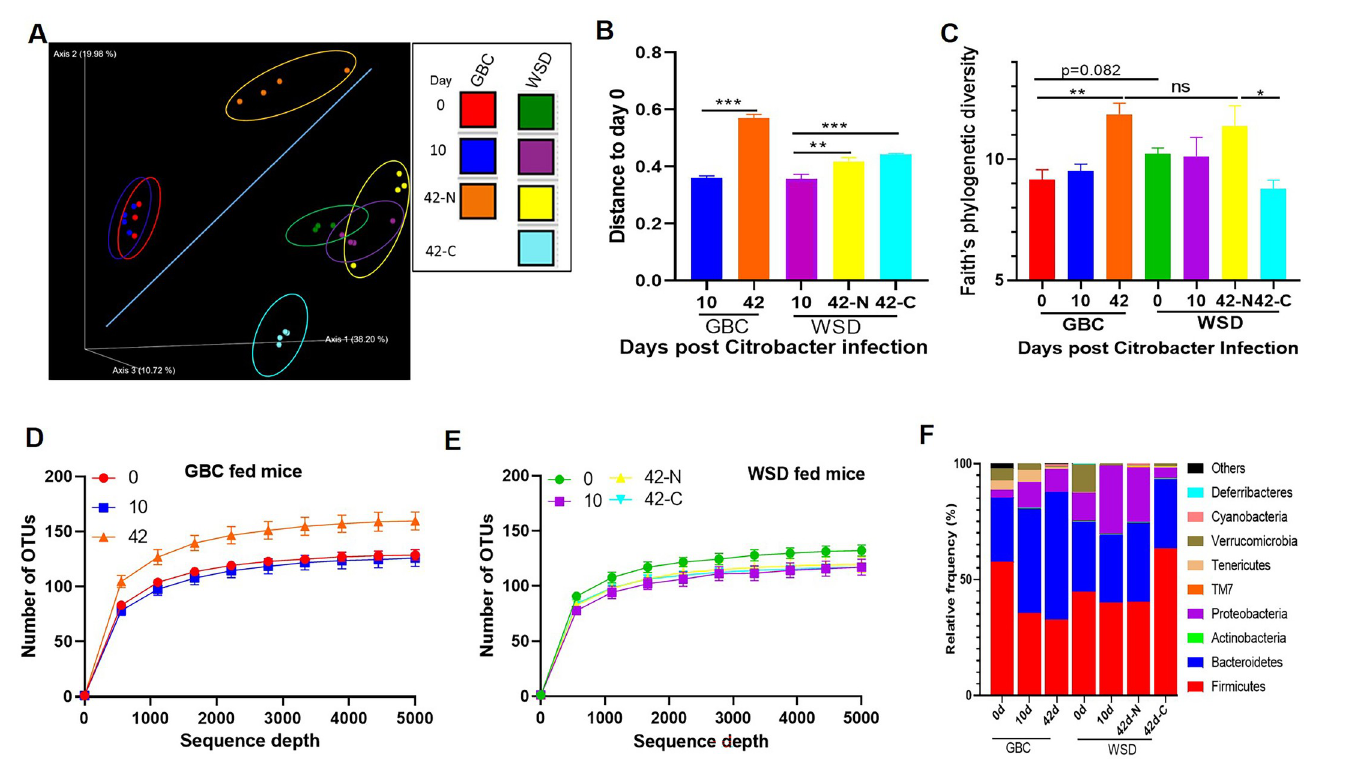
Fig 5. C . rodentium starkly alters microbiota of mice fed GBC but not WSD. A-B . Analysis of gut microbiota composition based on 16s rRNA sequencing and analyzed/displayed by unweighted UniFrac PCoA (A), UniFrac distances between Day 10 or 42 after C . rodentium infection relative to Day 0 (B). Alpha-diversity as measured by Faith’s PD (C) and observed OTUs (D&E). F . Relative abundance of bacteria at the phylum level.